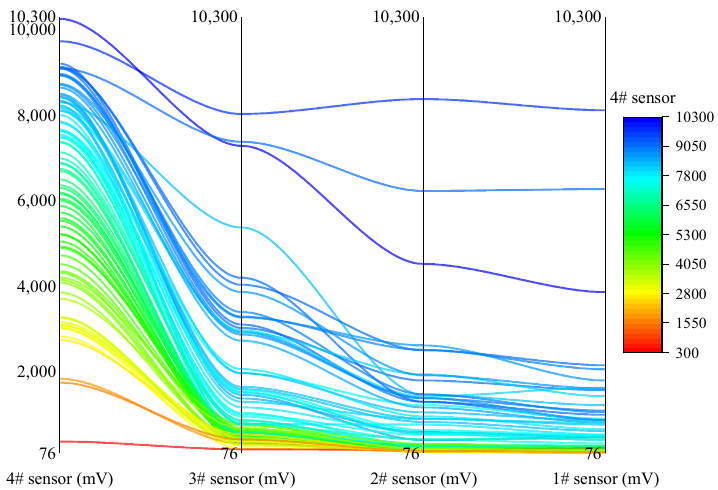
Figure 9. Amplitude variation of each statistical event.